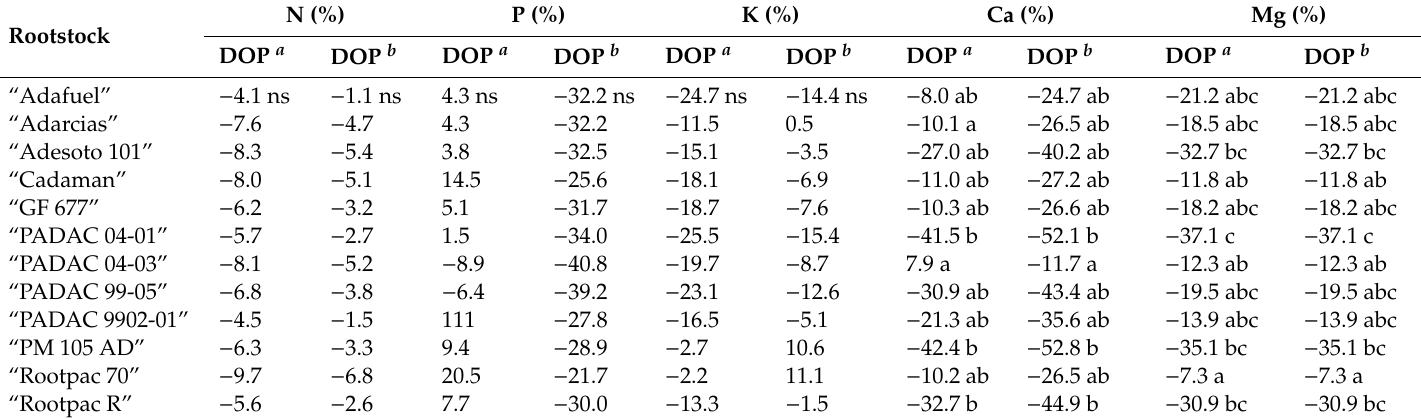
Table 11. Rootstock e ff ect on DOP index for each macro elements of “Big Top” cultivar on twelve